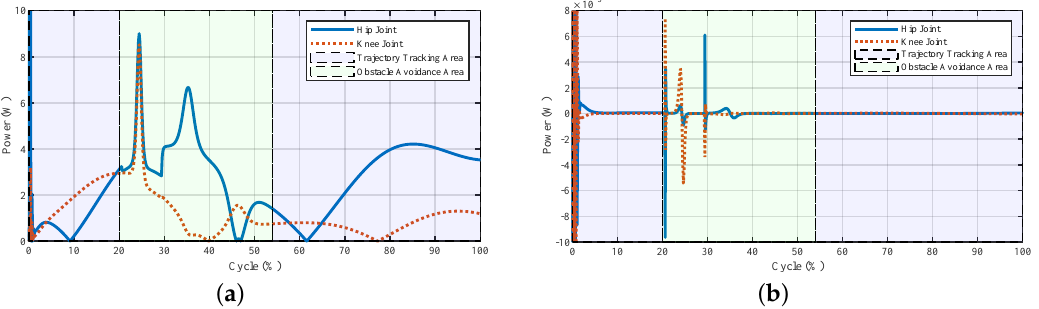
Figure 4. Joint powers of the system during stepping over the obstacle. ( a ) Powers of the exoskeleton and ( b ) powers of the interaction. The interaction powers reflect how much power was output by the pilot to drive the exoskeleton or power the robot outputted to help the pilot.